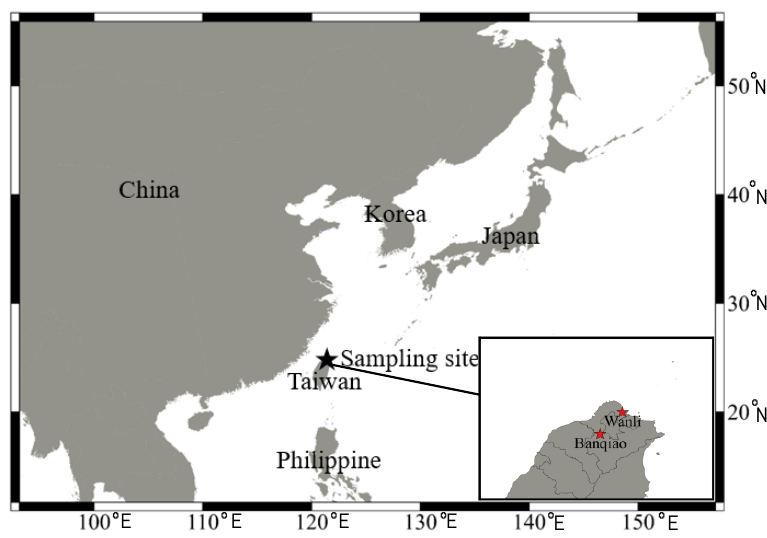
Figure 1. Map of the study area, sampling sites.